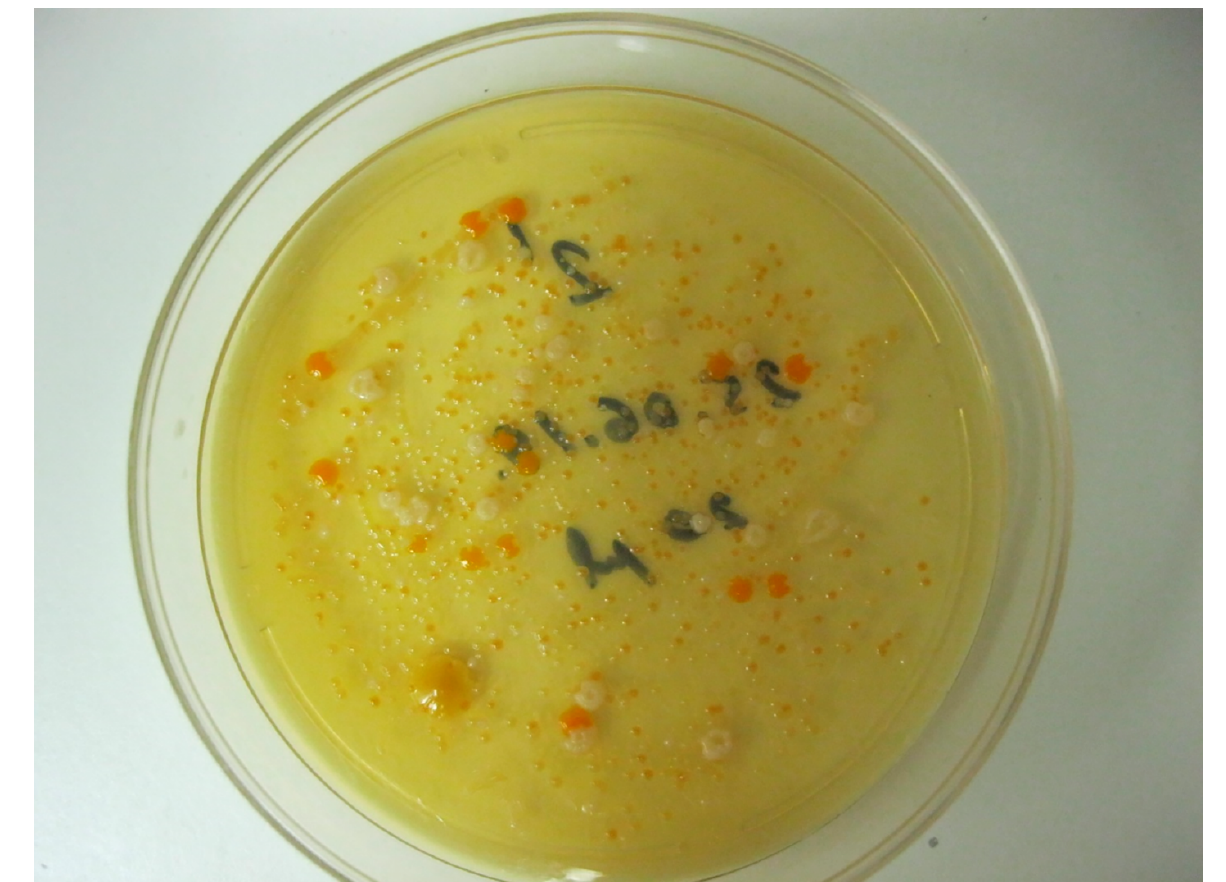
Figure 2. Typical view of a Petri dish with 1× LB agar after plating 0.5 mL of a water sample and incubation for 3 days at room temperature .